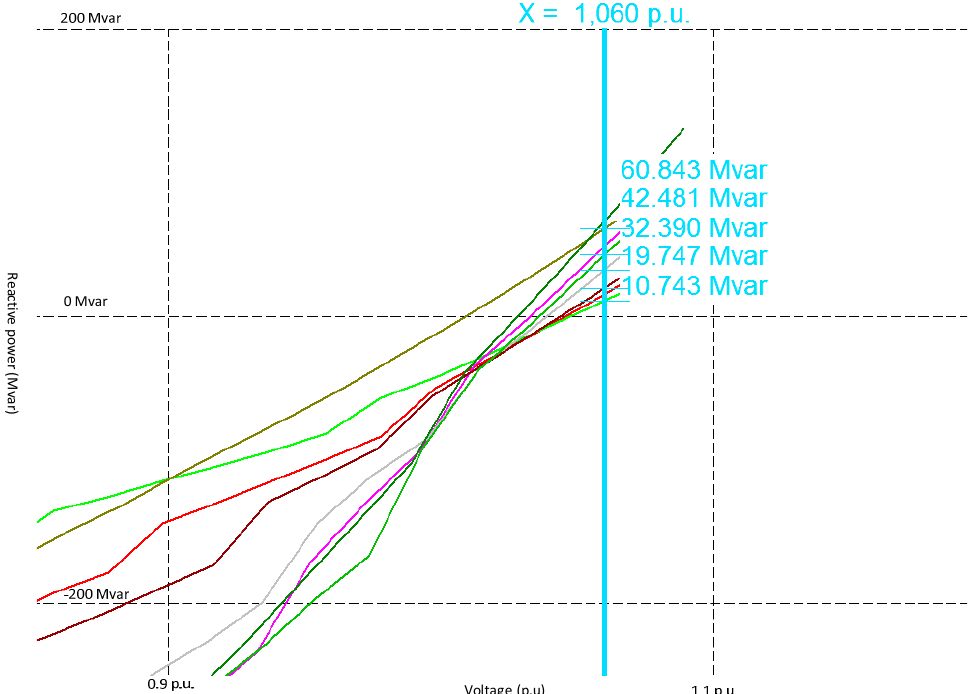
Figure 8. QV-analysis of the 3rd contingency, in the southern area of Zealand, after the added 100 Mvar Figure 8. QV ‐ analysis of the 3 rd contingency, in the southern area of Zealand, after the added 100 reactor at Mvar reactor at RAD.